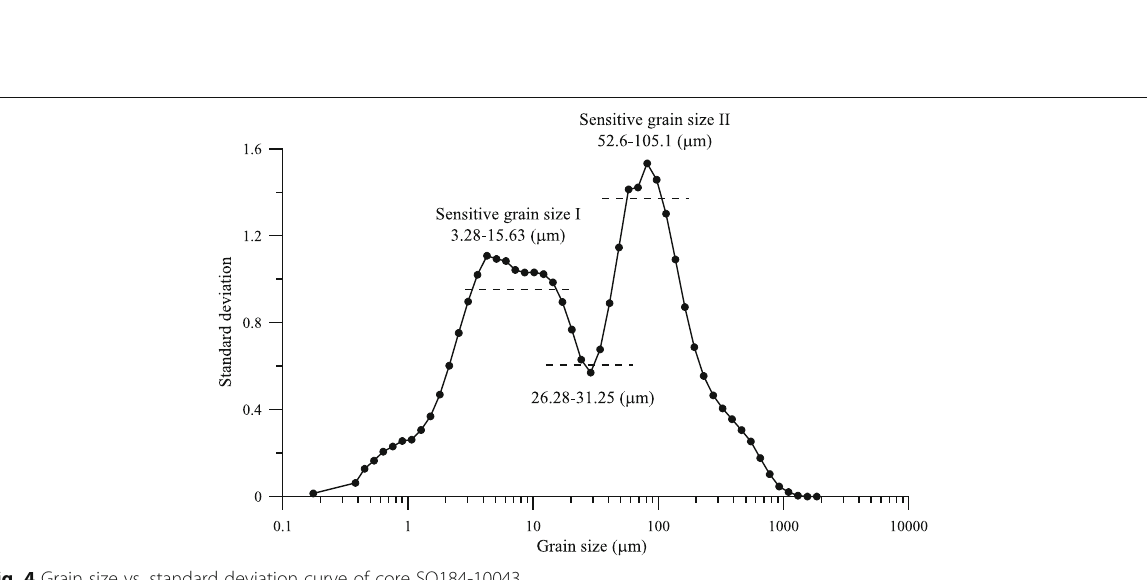
Fig. 4 Grain size vs. standard deviation curve of core